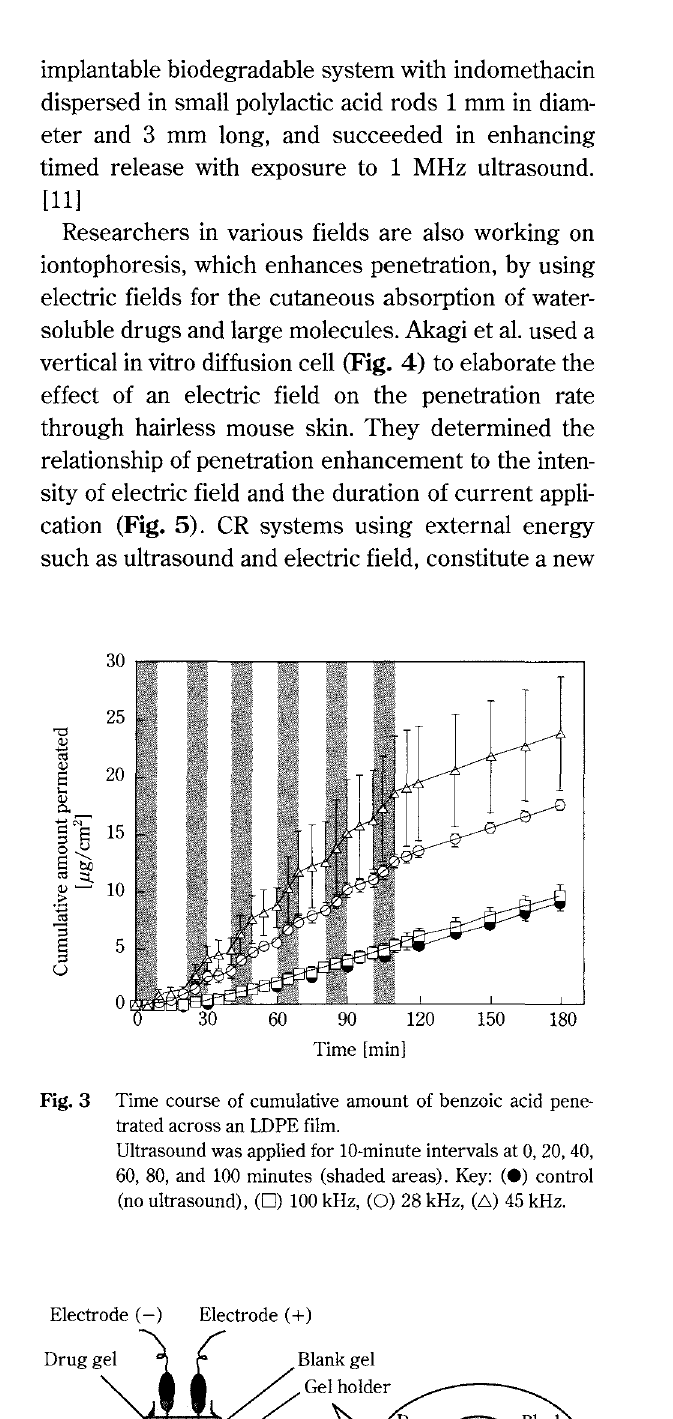
Fig.2 Experimental setup for measuring the effect of ultrasound on the membrane permeation of drugs. The side-by-side diffusion cell system is placed in the ultrasonic water bath washer. Model drug: benzoic acid; donor concentration: saturated concentration; effective volume: 68 ml; effective area: 12.5 cm 2; membrane; LDPE (50 Jlm in thickness); temperature: 37°C.